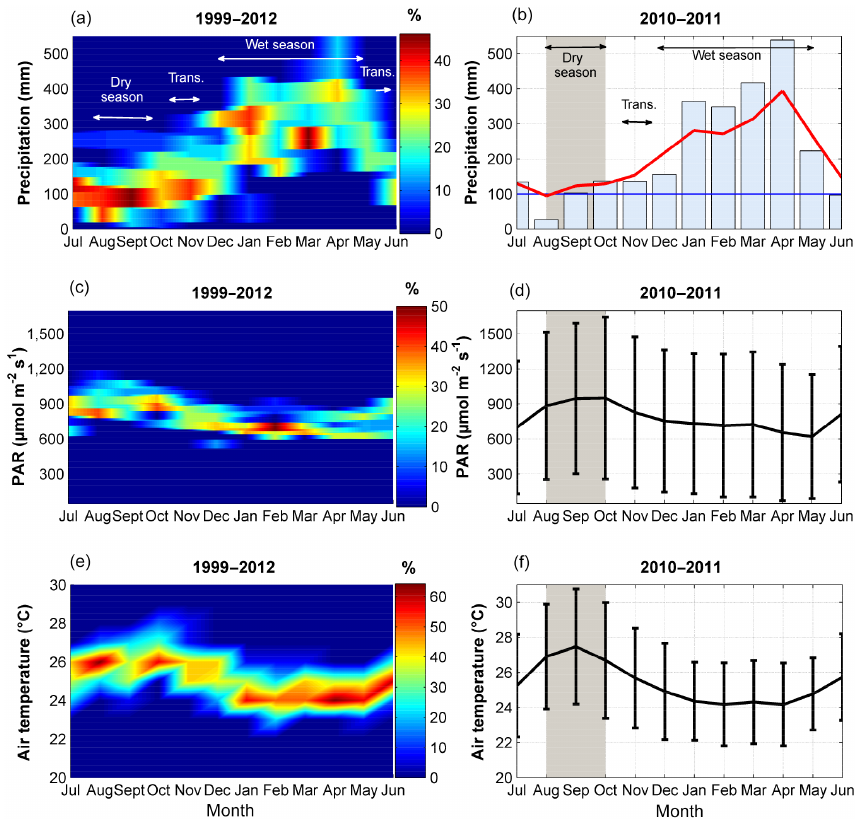
Figure 1. Precipitation, PAR and air temperature measured at K34 tower ( ∼ 2km far of TT34 tower): (a) relative frequency (%) of monthly cumulative precipitation from 1999 to 2012; (b) monthly cumulative precipitation from July 2010 to June 2011 (measured in 30min intervals for 24h) (bars), and average of monthly cumulative precipitation from 1999 to 2012 (red line); (c) relative frequency of monthly PAR from 1999 to 2012 (measured every 30min during 06:00–18:00, LT); (d) monthly average PAR from July 2010 to June 2011 (measured every 30min during 06:00–18:00, LT); (e) relative frequency of monthly air temperature from 1999 to 2012; (f) monthly average air temperature from July 2010 to June 2011 (measured in 30min intervals for 24h). Figures on the right side cover the period of this study; grey areas represent the period of dry season; and blue line at (b) represents 100mmmonth − 1 . Error bars represent 1 standard